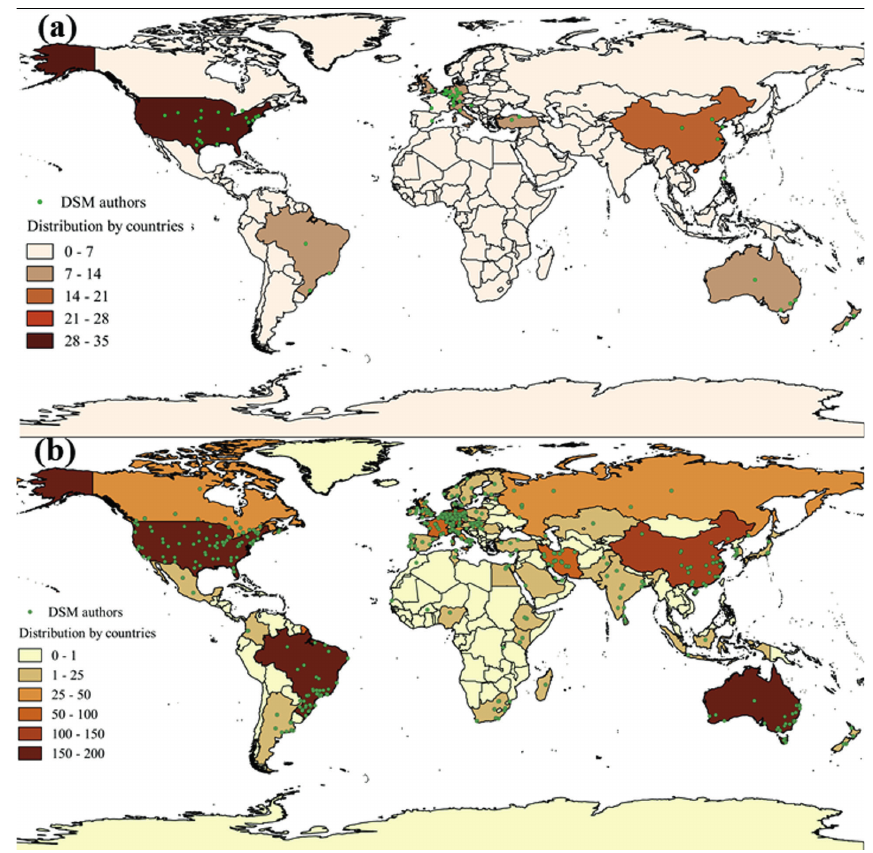
Figure 4 - Geographical distribution of authors of papers on DSM, (a) first decade of analysis from 1996 to 2007 and (b) second decade of analysis from 1996 to